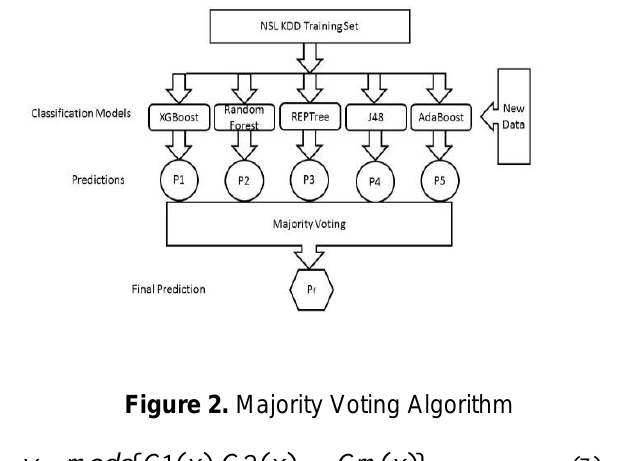
Figure 2. Majority Voting